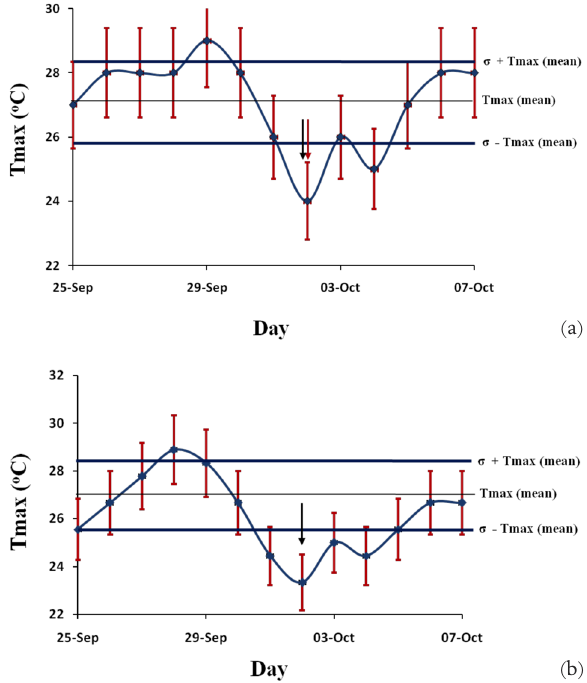
Figure 10. Day to day variations of the maximum temperature (Tmax) from September 25, 2012, to October 07, 2012, recorded at the (a) epicenter site and (b) at GU, during October 1, EQ event. The standard deviation magnitude of Tmax from the average values is shown by thick blue lines. The day of attaining a sudden mini- mum in temperature is marked by red arrow head while the black arrow shows the EQ